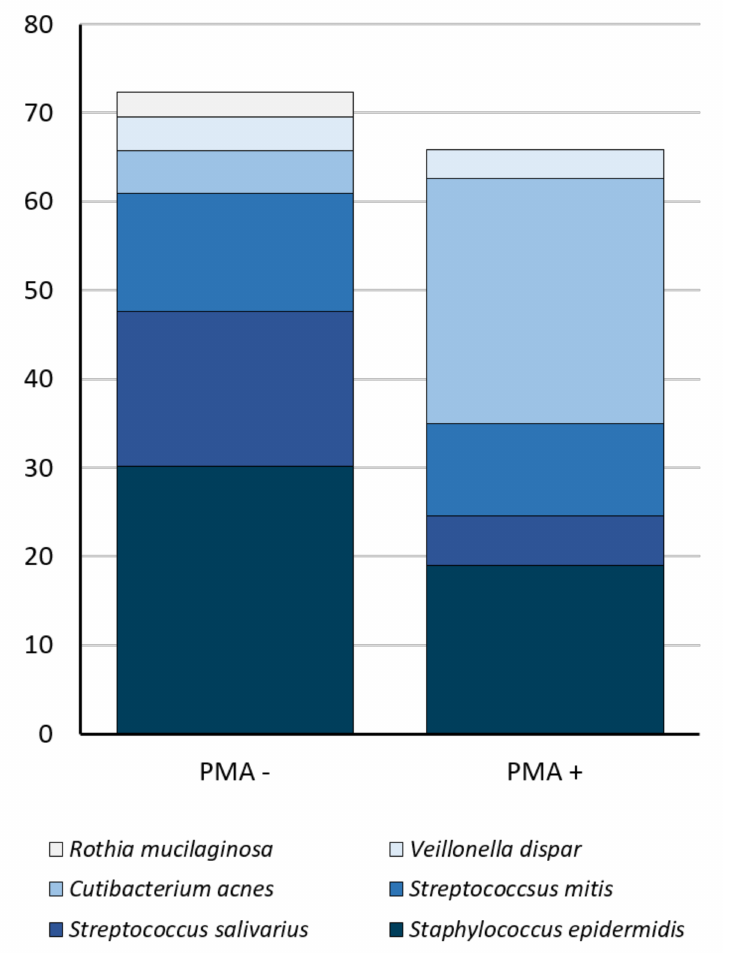
Figure 3. Bacterial DNA profiles differed in PMA-treated (PMA+) and untreated (PMA-) samples. The relative abundance (%) of the six OTUs occurred at a relative abundance of ≥ 1% and prevalence of ≥ 10% are shown